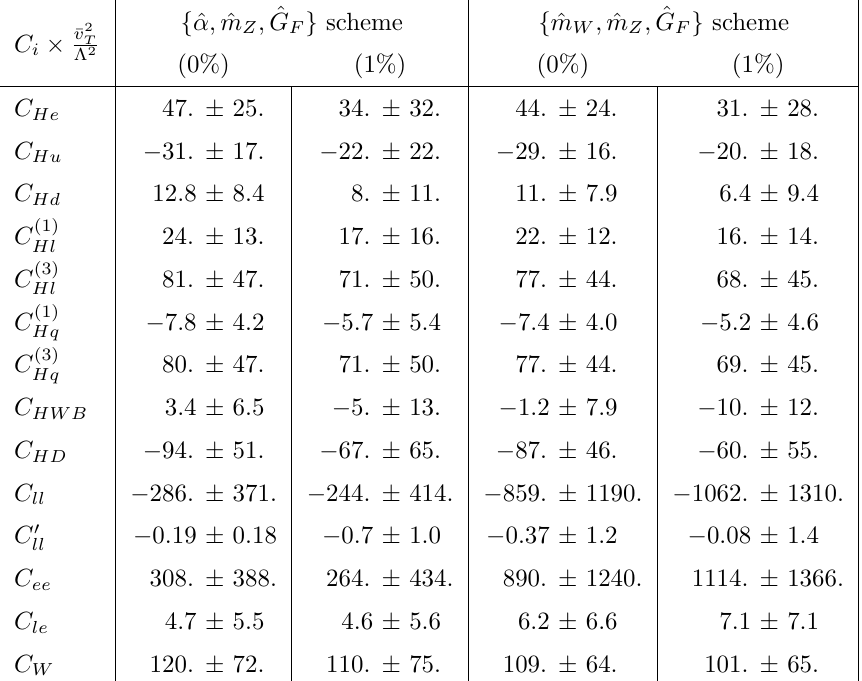
0% ; 1% and for f g